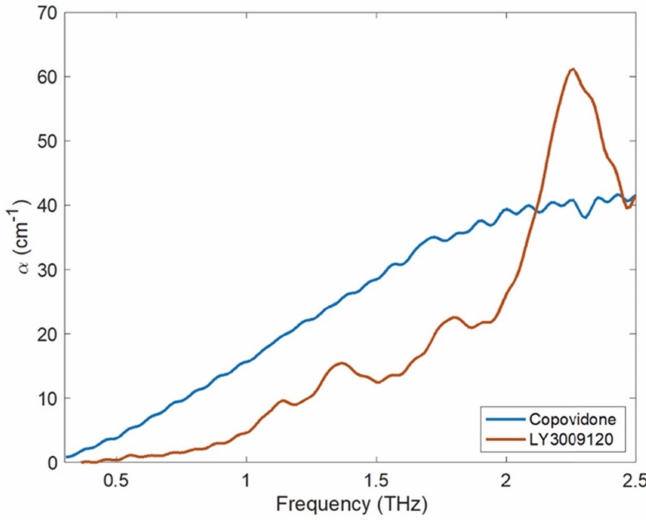
Figure 6. The THz absorption coefficient of co-povidone (amorphous) and LY3009120 as measured using THz-TD. Adapted from [159] under Creative Commons Attribution (CC BY) license (https: